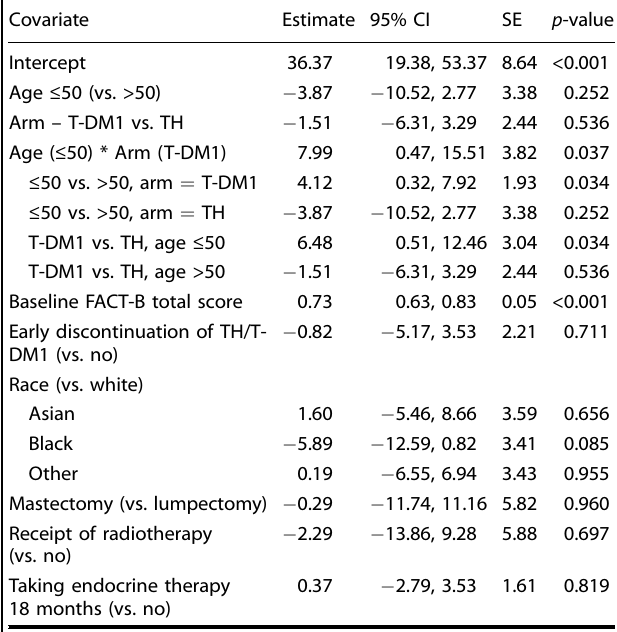
Table 4. Multivariable linear regression model for mean difference in 18-month post-enrollment FACT-B total